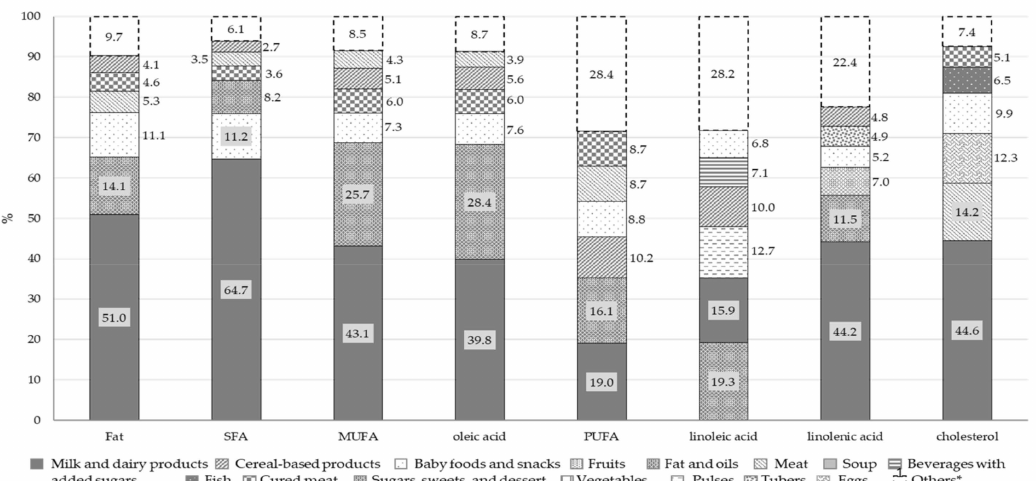
Figure 4. Percentage contribution of selected food groups to total intake of fats ( n = 389). * For each variable, the category “Others” includes all the food groups not considered independently. Abbreviation: SFA, saturated fatty acids; MUFA, monounsaturated fatty acids; PUFA, polyunsaturated fatty